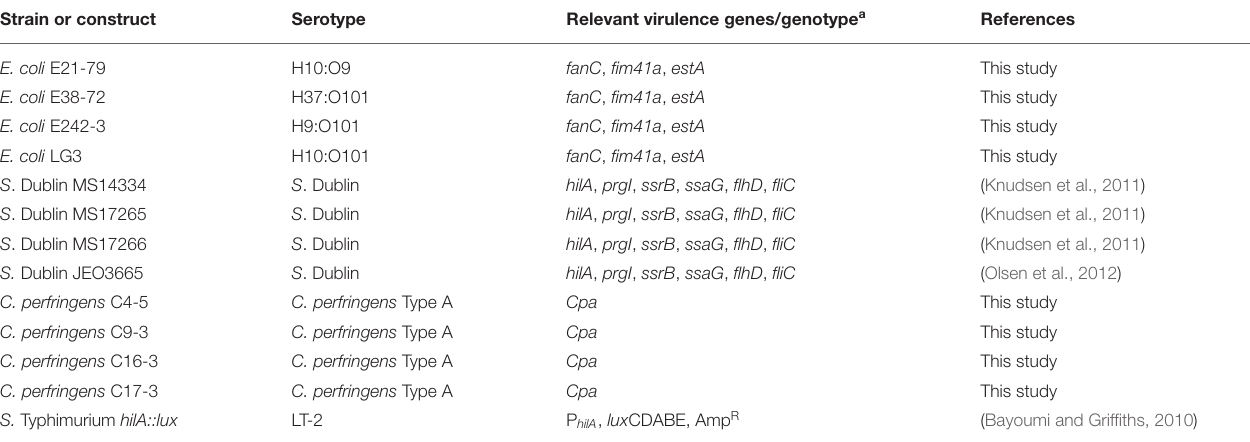
TABLE 1 | Strains of pathogenic bacteria used in this